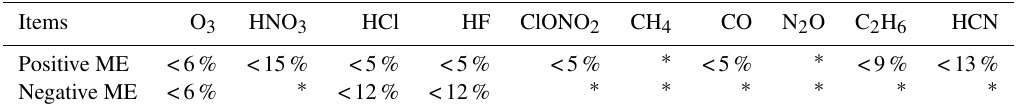
Figure 20. Fractional difference in the total column, the rms, the total uncertainty, and DOFs as a function of the SZA from August 2015 to August 2016, for which the ILS j with a maximum ME deviation of 5% is used. Table 4. Recommendations for suppressing the fractional difference in the total column for ClONO 2 and other NDACC gases within 10 and 1%,